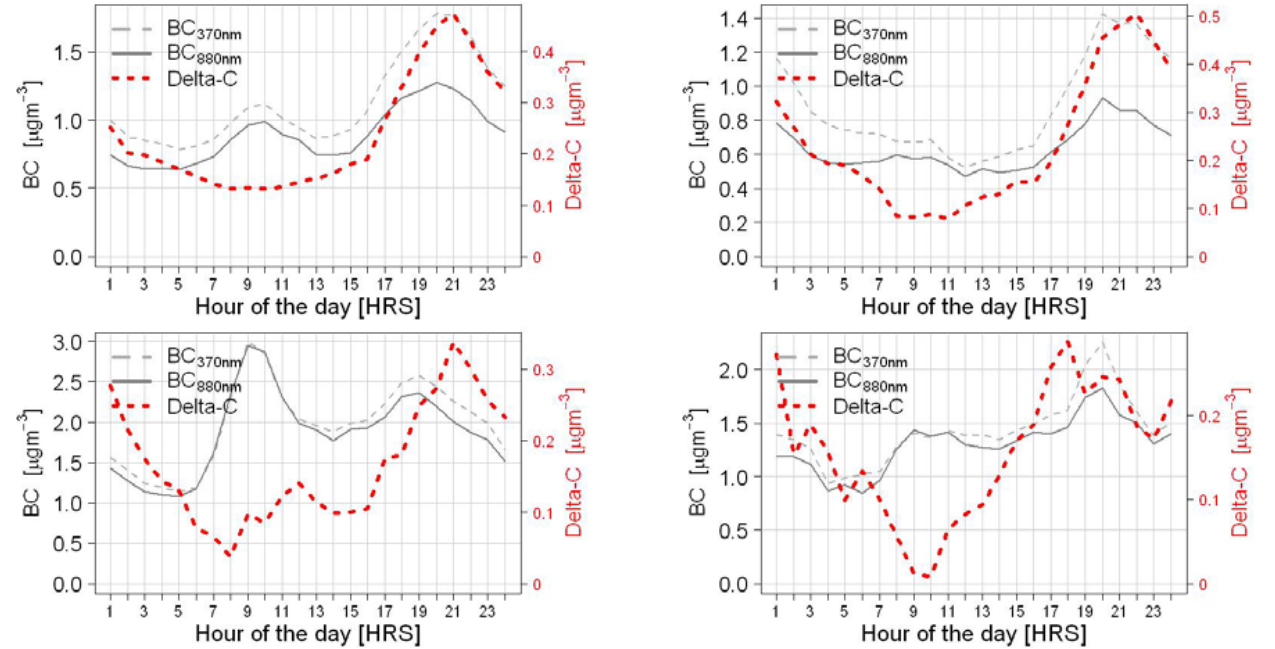
Fig. 6. Average diurnal variation in black carbon estimated at 370 and 880nm with the aethalometer and Delta-C at Budbrooke (top panel) and North Kensington, winter (bottom panel). Left plot: weekday; right plot: